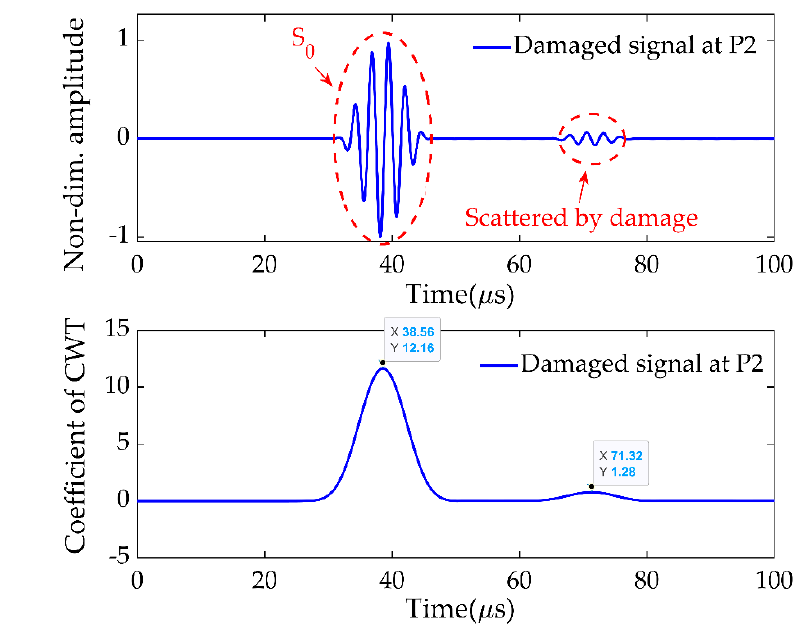
Figure 7. ( a ) Signal received at P2 in the damaged plate. ( b ) CWT of ( a ).